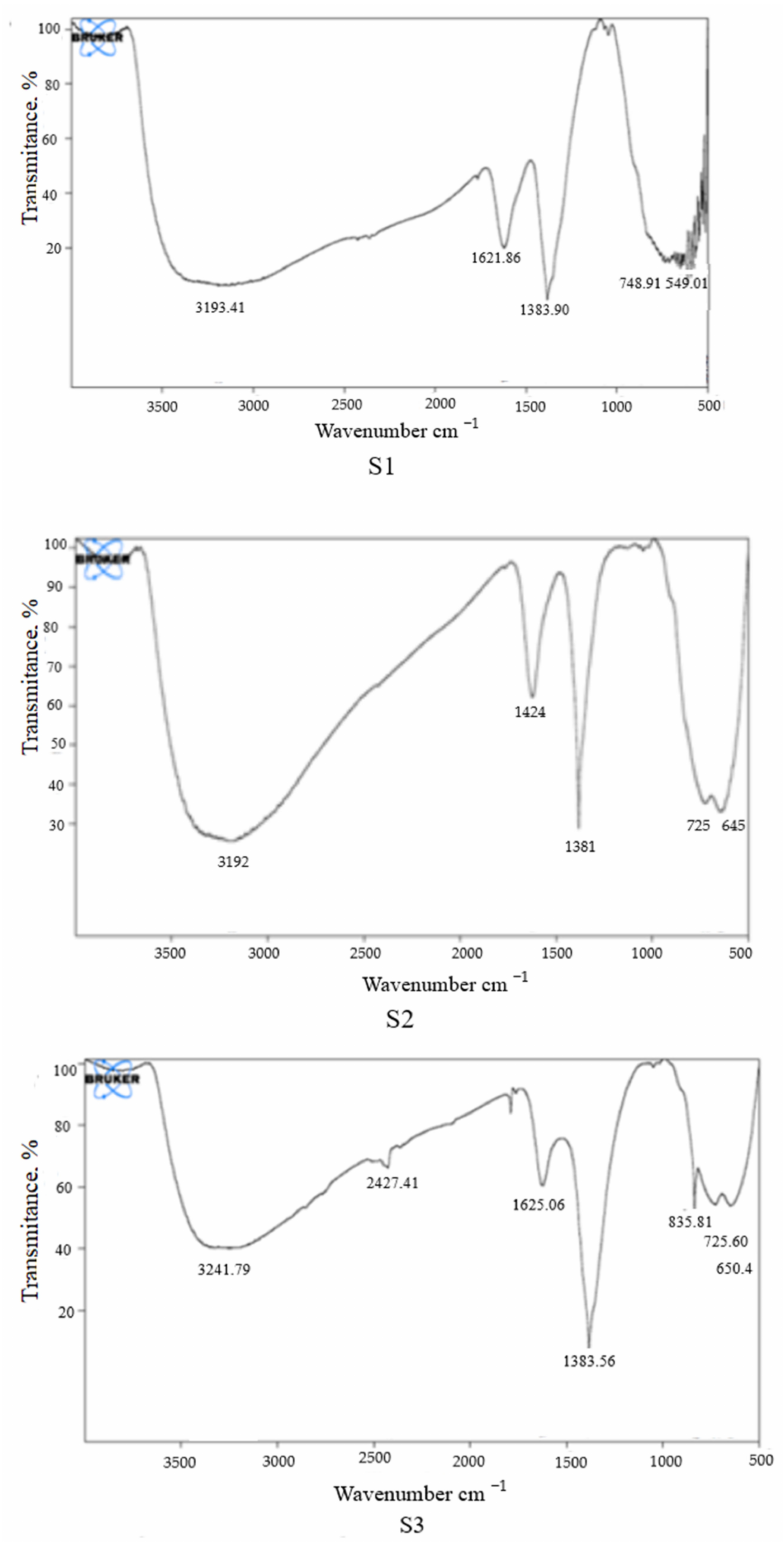
Figure 4. FTIR spectra of the